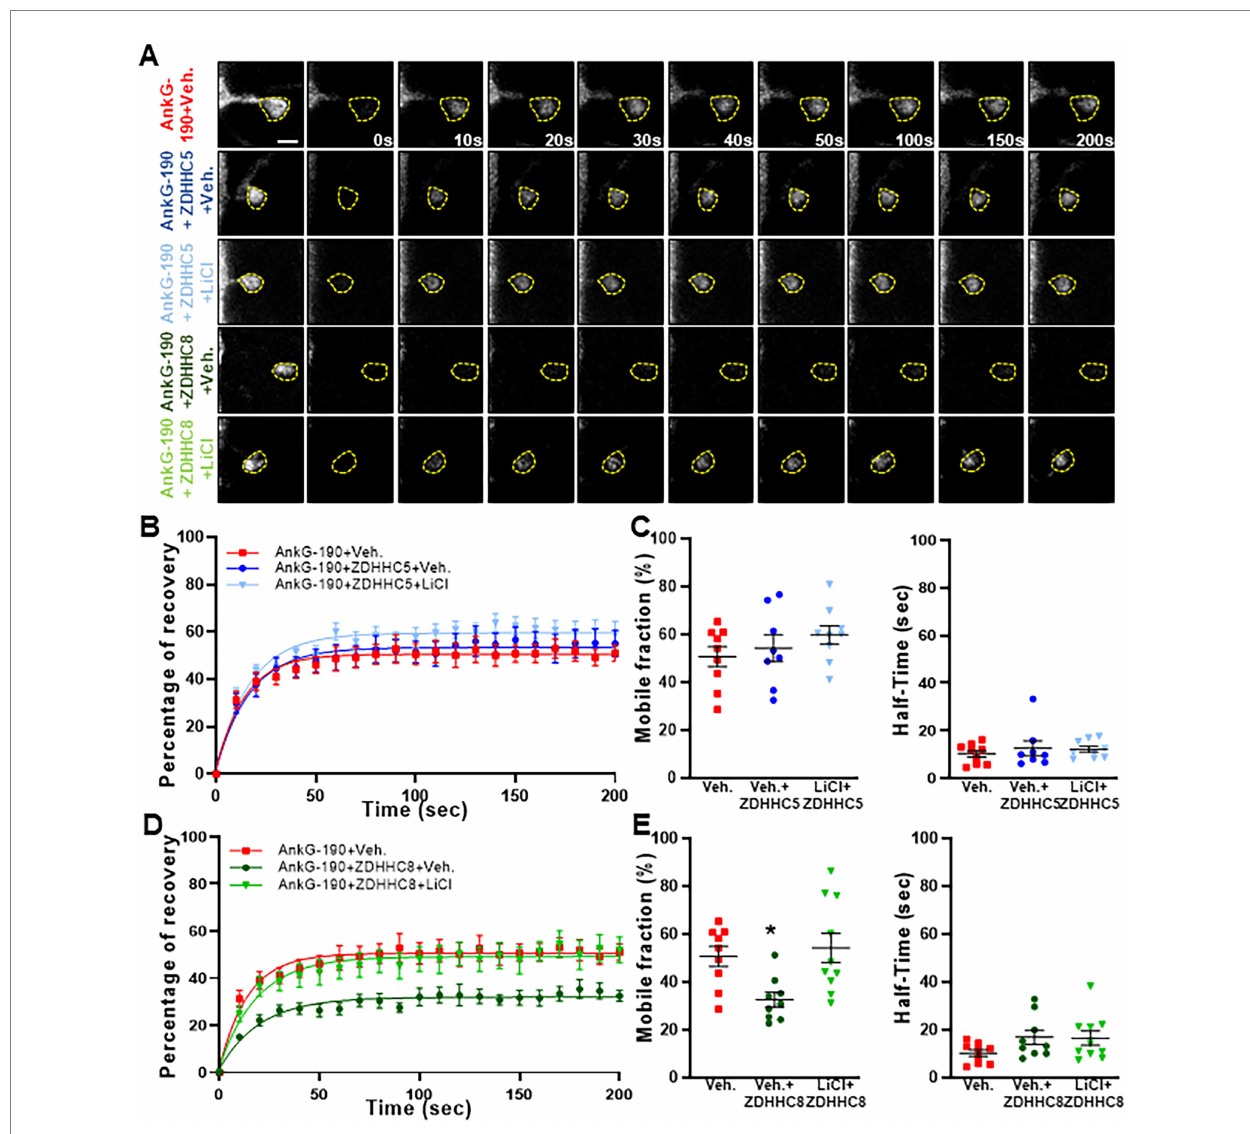
FIGURE 4 Lithium prevents ZDHHC8 to stabilize AnkG-190 in dendritic spines. (A) Representative time-lapse images of GFP-AnkG-190 fluorescence in 24 days rat neurons culture overexpressing GFP-AnkG-190 with or without ZDHHC5 or ZDHHC8 during 3 days in FRAP experiments, scale = 2 μ m. Cultures are treated with palmostatin B +/ − lithium chloride 24 h prior to the experiment. (B) Quantification of GFP fluorescence in spines over time. Data are fitted with single exponentials (colored lines). Data are represented as mean ± SEM. (C) Scatter plots of mobile fraction (left) or half-time recovery (right) of GFP-AnkG-190 in the presence or absence of ZDHHC5 +/ − lithium chloride ( n = 8–10 neurons, one-way ANOVA with Dunnett’s post-test). (D) Quantification of GFP fluorescence in spines over time. Data are fitted with single exponentials (colored lines). Data are represented as mean ± SEM. (E) Scatter plots of mobile fraction (left) or half-time recovery (right) of GFP-AnkG-190 in the presence or absence of ZDHHC8 +/ − lithium chloride ( n = 8–10 neurons, one-way ANOVA with Dunnett’s post-test, * p < 0.05, ±SEM) B and D share the same control and only one-way ANOVA was performed for the mobile fraction and the half-time including the 5 conditions and separated between C and E for better